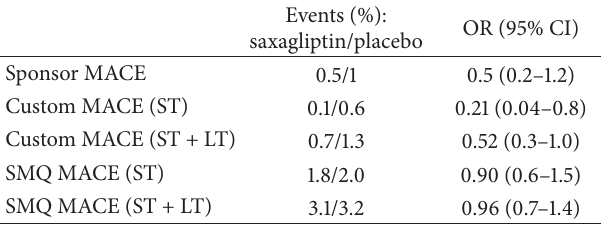
Table 6: Saxagliptin polled phase 2b/3 MACE